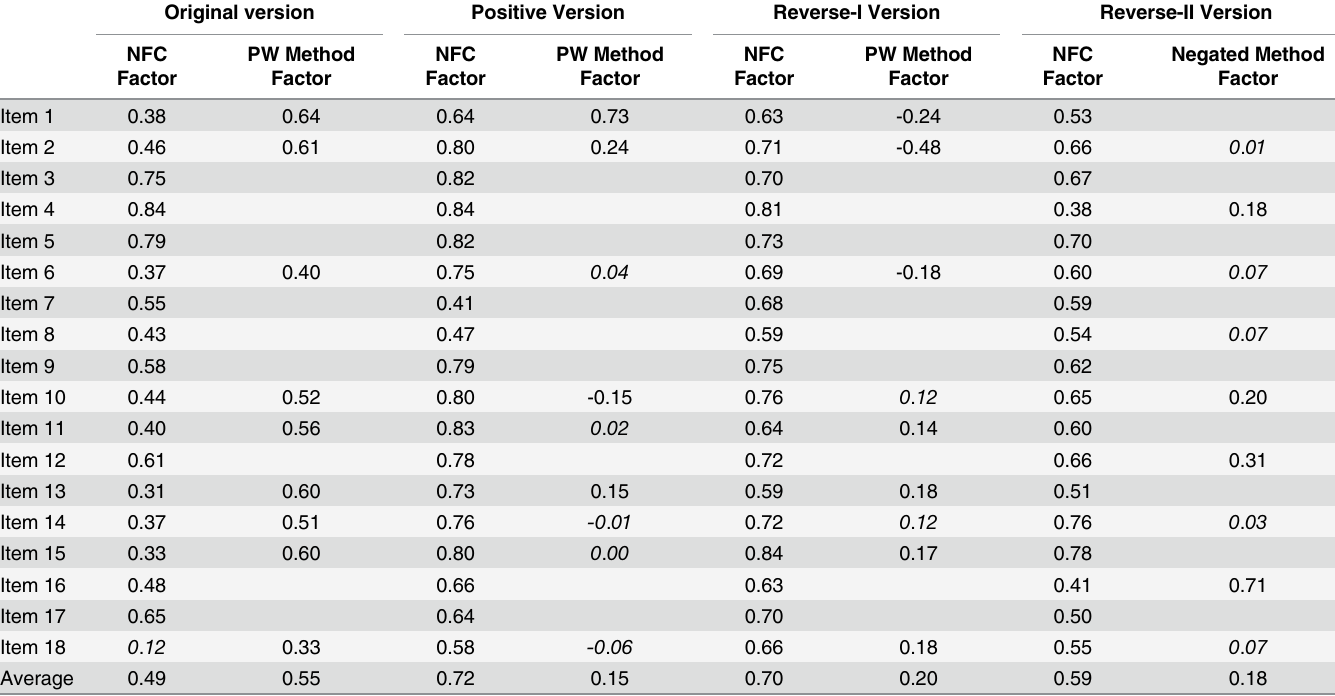
Table 7. Standardized Factor Loadings of Model 4 for the Four Scale